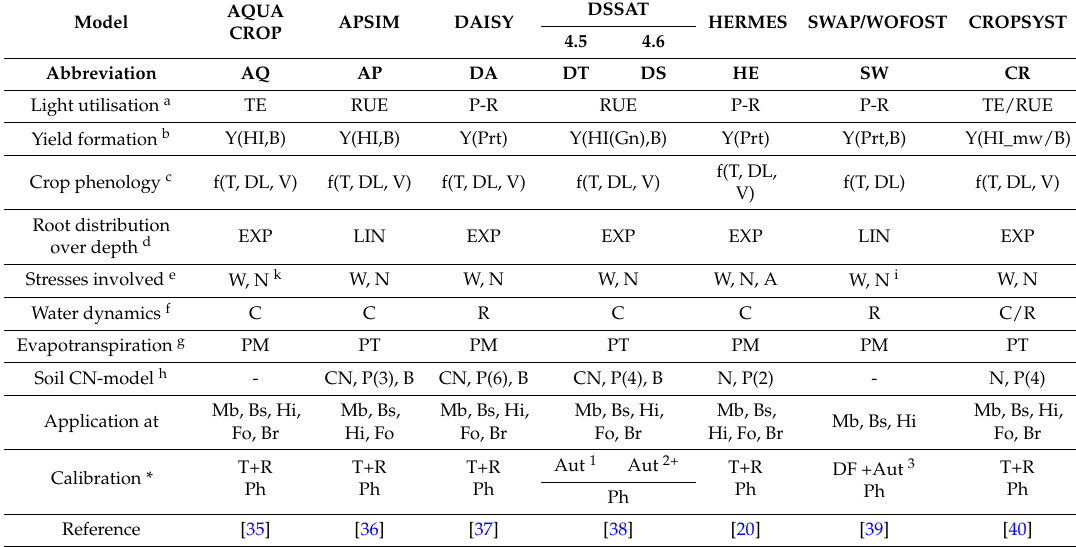
Table 2. Main characteristics of participating